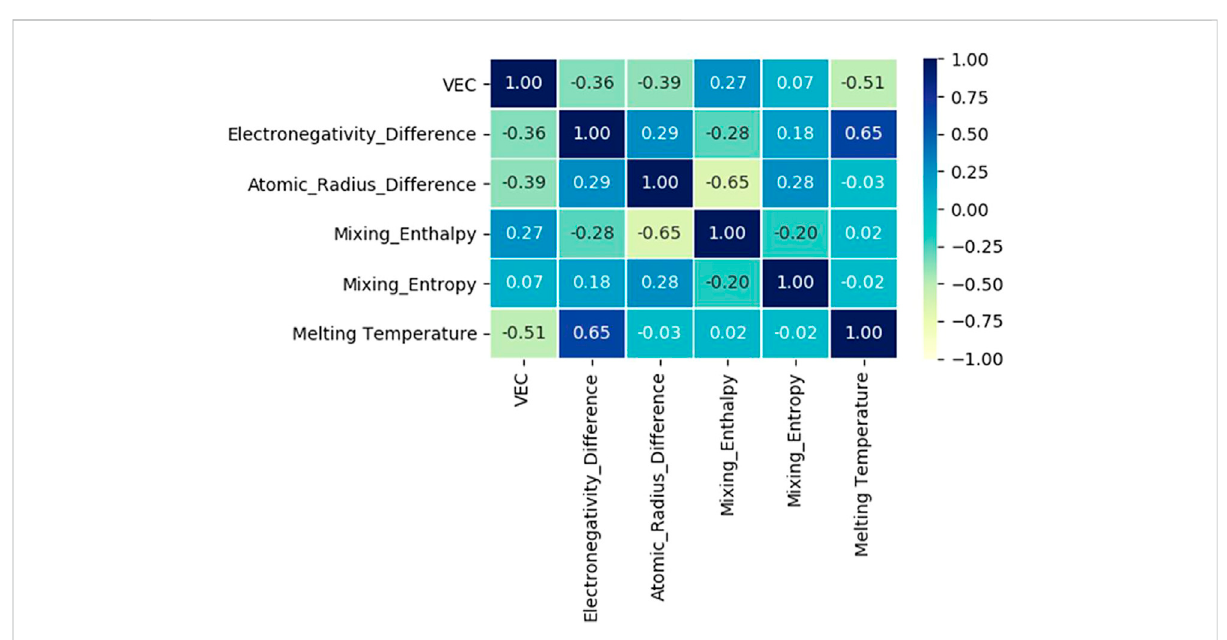
FIGURE 5 Heatmap of the correlation matrix between six relevant features, including VEC, electronegativity difference, mixing enthalpy, atomic size difference, mixing entropy, and melting temperature (Zhu et al.,